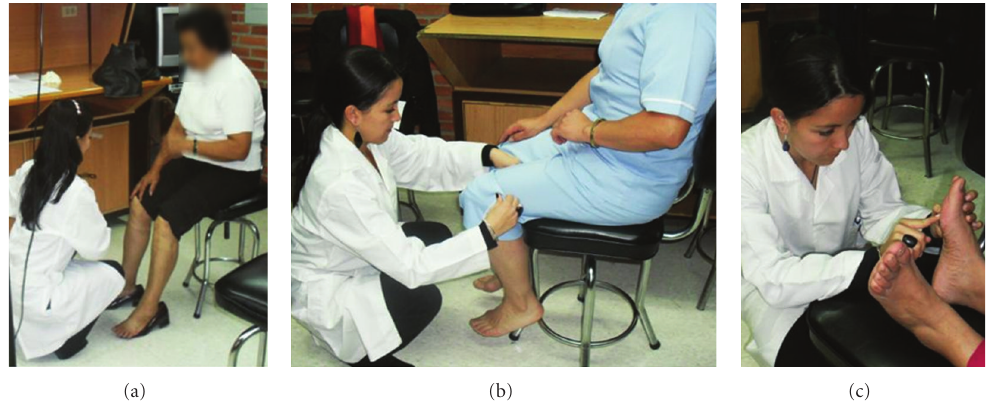
Figure 1: Physical examination of a subject prior to the